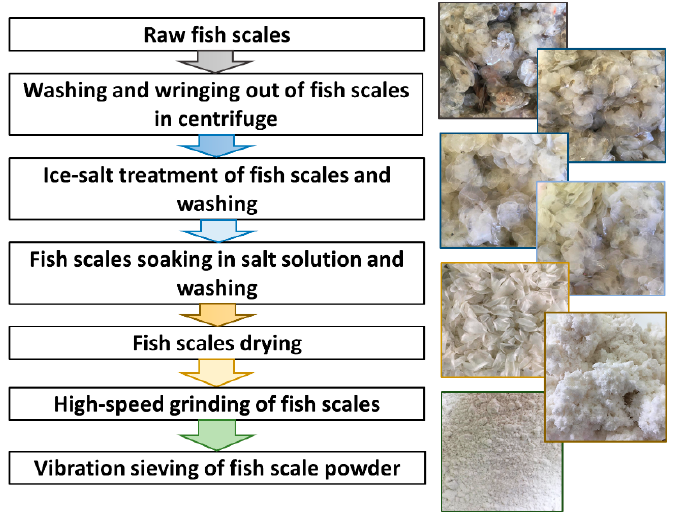
Figure 2. Scheme of preparation of fish scale powder enriched with inorganic components.